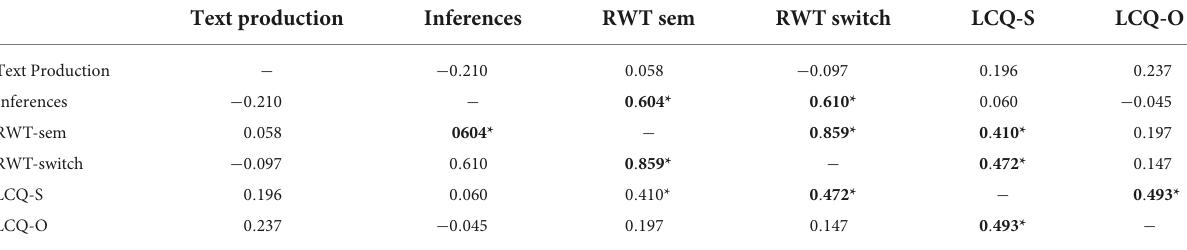
TABLE 6 Correlations between measures of executive functions and discourse performance for IwTBI ( N =